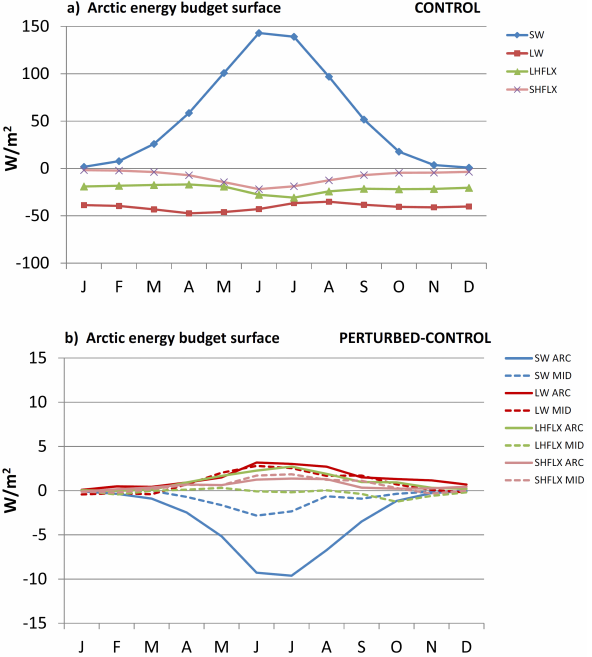
Fig. 13. Seasonal cycle of the Arctic mean energy fluxes at the sur- face for (a) the CONTROL run and (b) the changes in the radiative fluxes ARC-CONTROL (solid) and MID-CONTROL (dashed); net SW radiation (blue); net LW radiation (red); latent heat flux (green) and sensible heat flux (pink). All units in Wm − 2